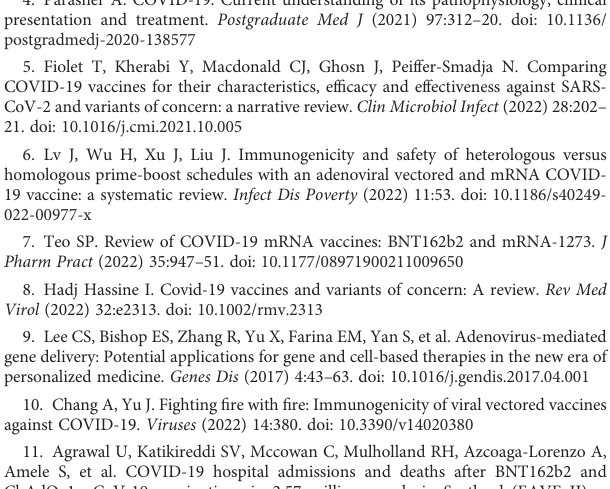
SUPPLEMENTARY TABLE 2 IFS results of DT and RF on lists yielded by different feature ranking algorithms in three immune cell types.